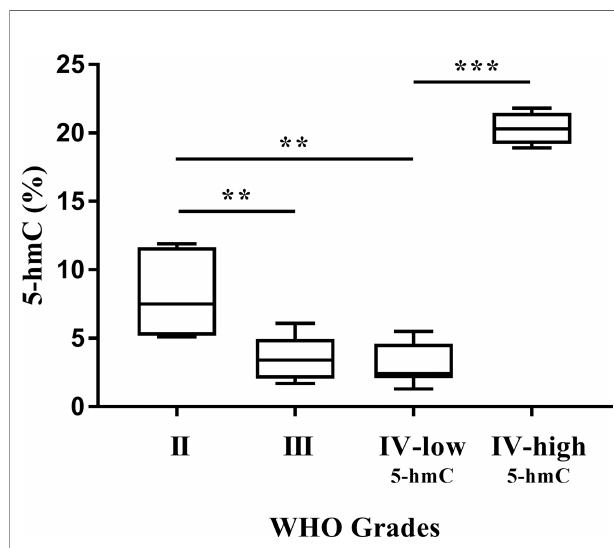
FIGURE 1 | Global 5-hmC abundance (%) in gliomas. Increasing WHO grades of glioma are associated with a continuous decline in 5-hmC levels, except for glioblastoma (IV-low 5-hmC and IV-high 5-hmC ). Differences among group means were evaluated by one-way ANOVA test (**p < 0.01, ***p <